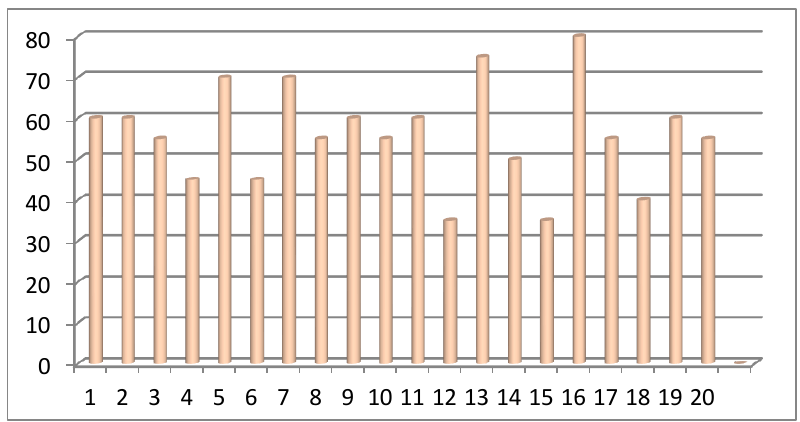
Figure 1. Diagram Result of the Test in Cycle